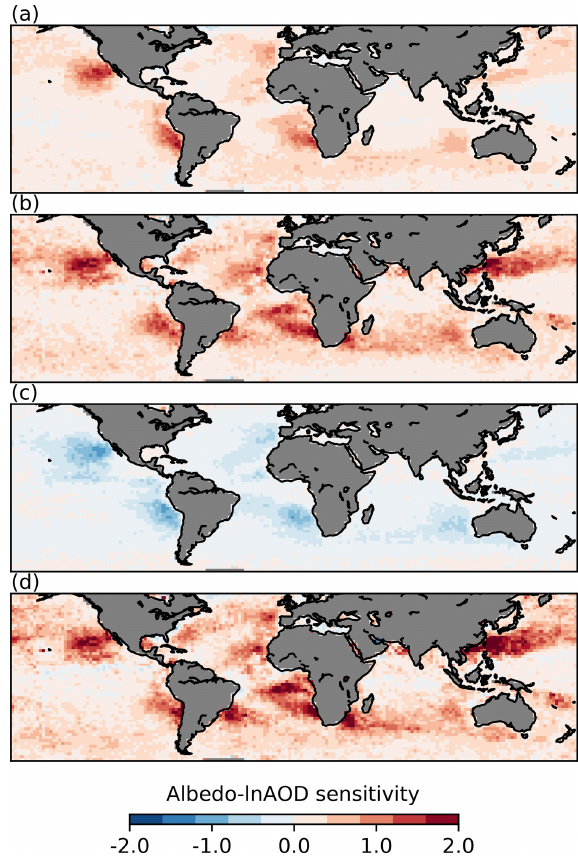
Figure 7. The sensitivity of cloud albedo to lnAOD variations (a linear sensitivity calculated from P(α | τ a ) ) through (a) N d changes (Twomey only), (b) CF changes (const. N d and LWP) and (c) LWP changes. Panel (d) shows the total sensitivity, which is calculated directly using Eq. (2), not as a linear sum of (a) – (c)